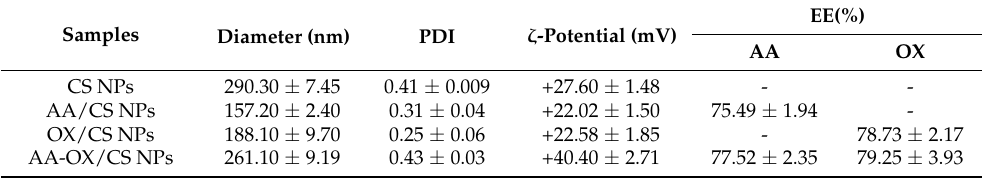
Table 1. Characterization of unmodified CS NPs, AA/CS NPs, OX/CS NPs and AA-OX/CS NPs. Data are means ± SD ( n = 3).